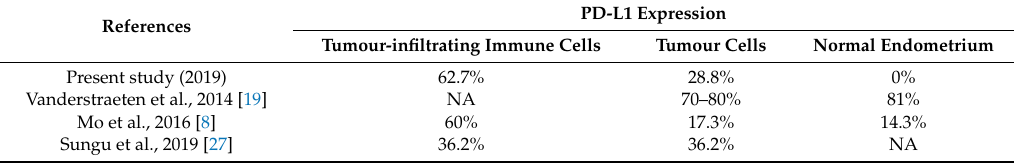
Table 4. Comparison of PD-L1 expression in present study with previous